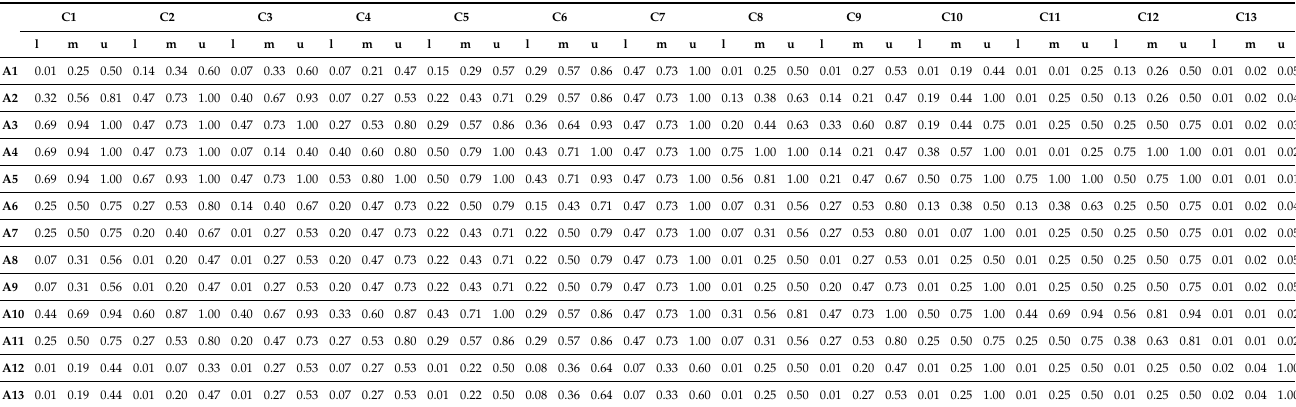
Table A7. Normalized fuzzy decision